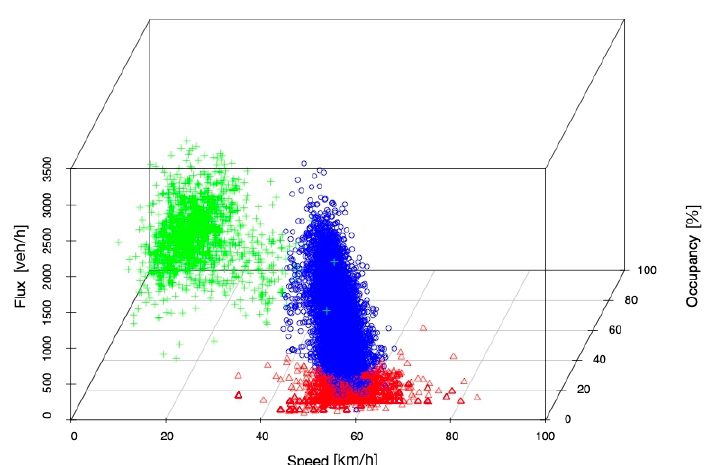
Figure 1. 3D visualization and cluster analysis results of Rome data suggest the existence of third phase (red) in addition to the free flow (blue) and congestion (green)